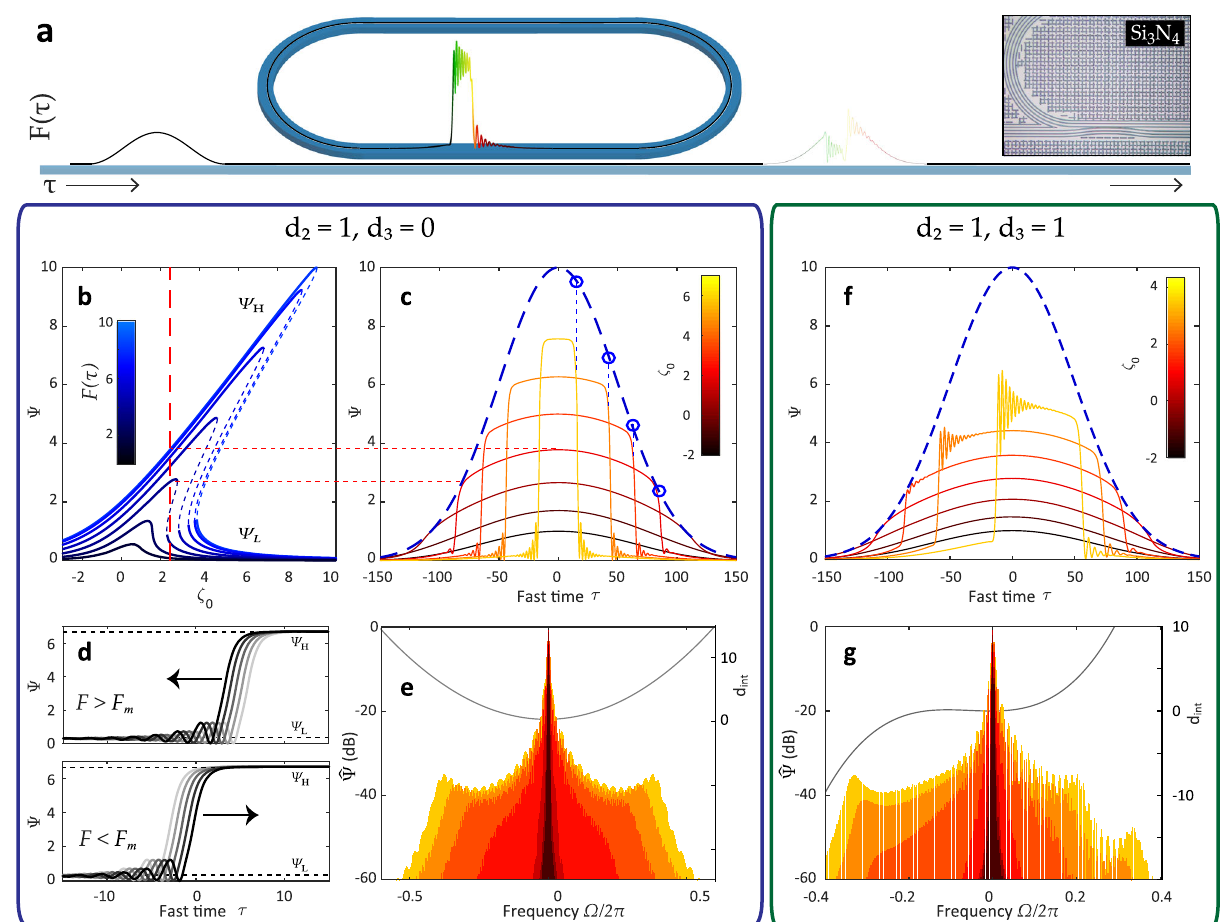
Fig. 2 | Excitation ofswitching waves inside pulse-drive envelope.a Principle of pulse-driven Kerr cavity dissipative structure formation, with image of resonator with coupling section. b – e SW formation in pure normal dispersion. b Contour of thebistableintracavityCWsolutions,plottedforincreasinglocalvalueofthepump F ( τ ), with stable (unstable) solution in solid (dashed) line. Red-dashed line marks detuning after wave-breaking occurs. c Development of intracavity fi eld (red-yel- low) within the pulse envelope (blue dashed) with increasing detuning ζ 0 . Red-